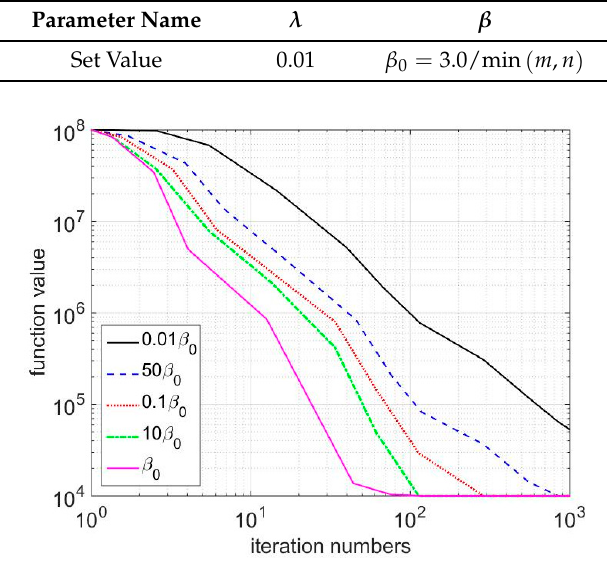
Figure 4. The performance of GBTR-ADMM in respect to different β .